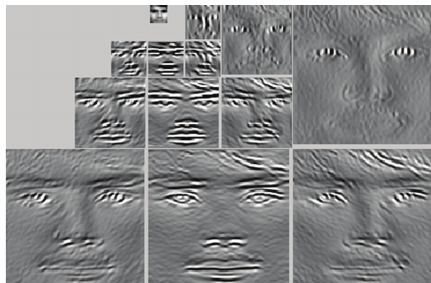
Figure 2: Steerable Pyramid Transform ( 𝐾 = 4 and 𝐽 = 3 ) on 𝑅 component of a cropped original color FERET image.